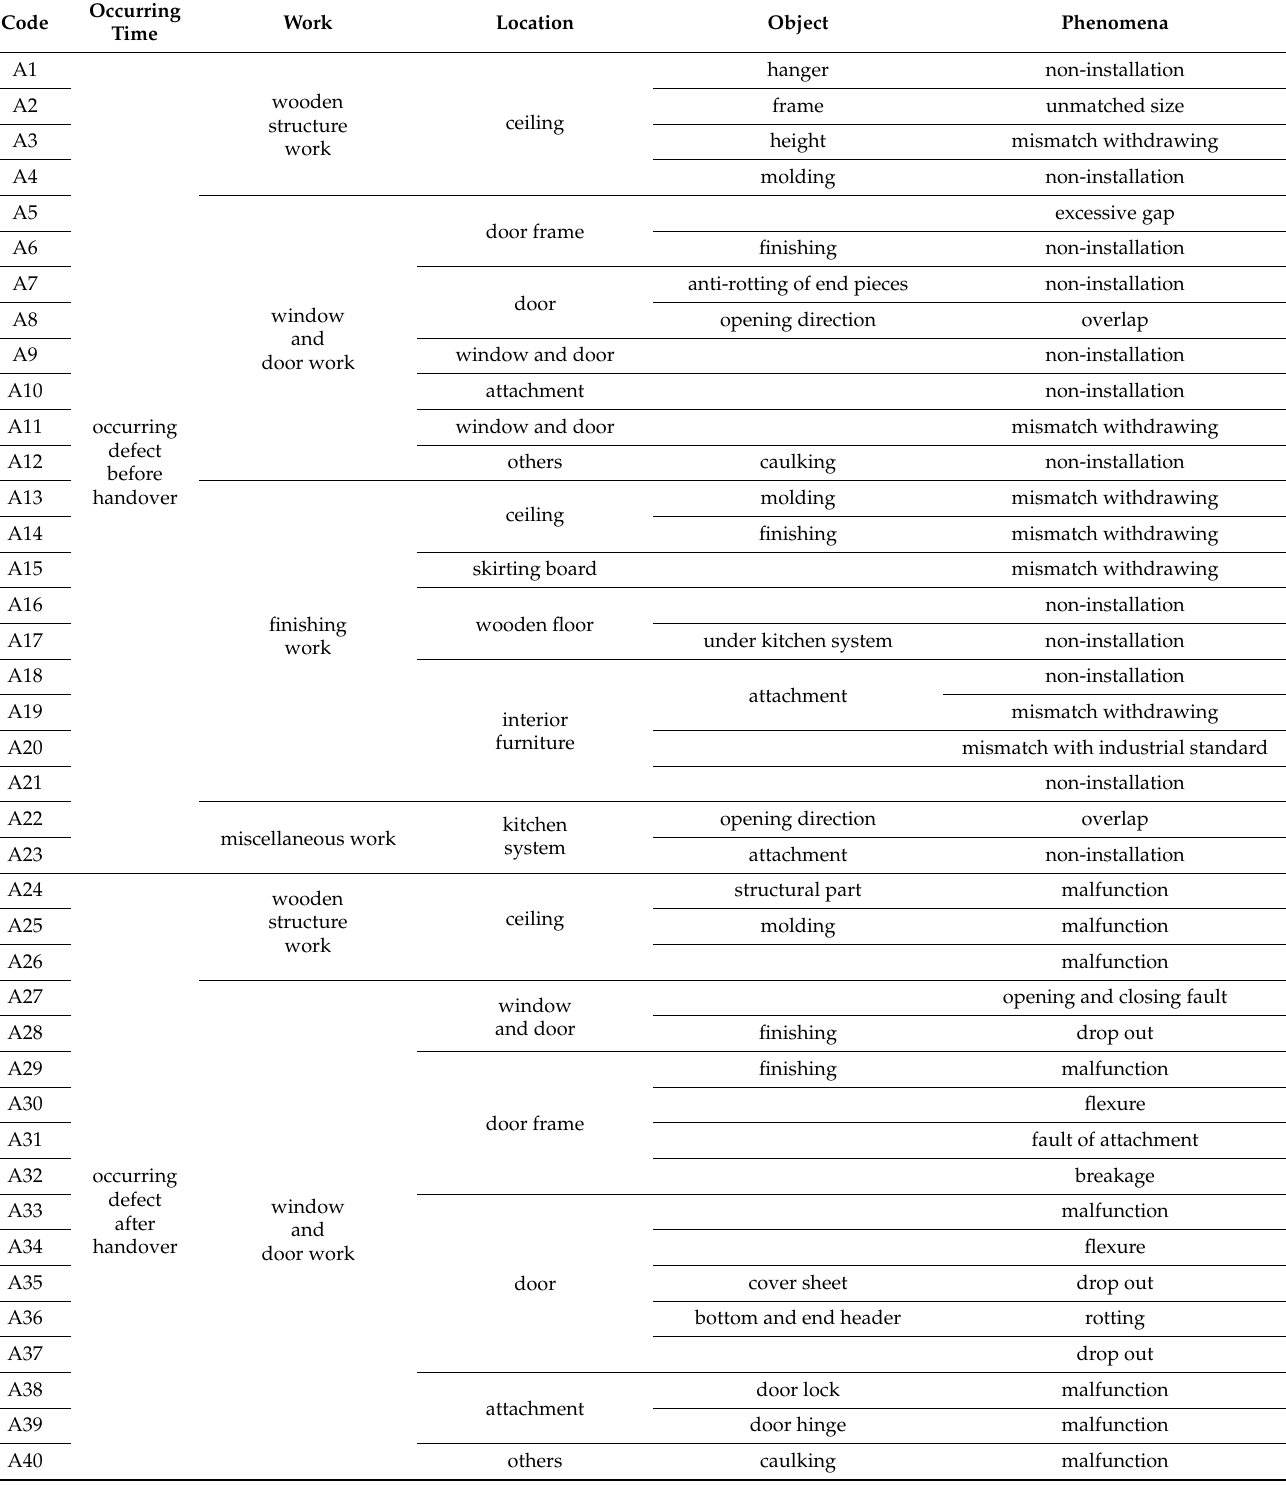
Table 2. Total defect index list of